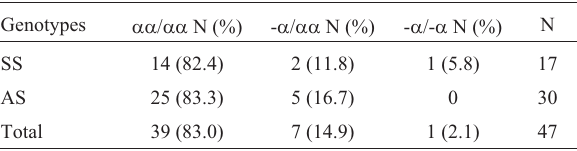
Table 1 - Frequency of the - (cid:3) 3.7kb thalassemia mutation in (cid:2) S -globin gene carriers.